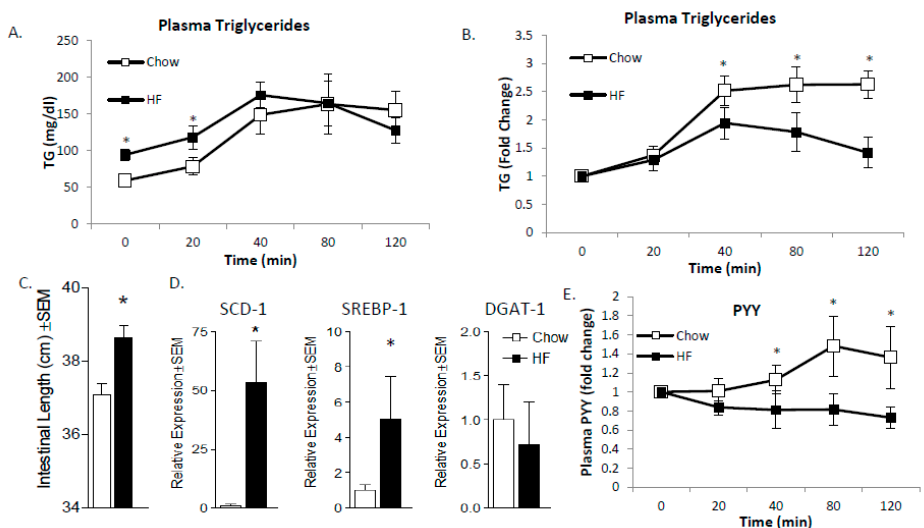
Figure 7. Intestine adaptations to HF diet. Mice were fed chow or high SFA diet for 12-weeks, then gavaged with an SFA-rich meal. Plasma TG following the gavage was measured as absolute ( A ) or relative ( B ). One week later, tissues were collected for analysis where intestinal length was measured and found to be longer in HF-fed mice ( C ). Additionally, lipogenic genes (SCD1 and SREBP1c but not DGAT1) were increased ( D ). High SFA-fed mice had lower satiety response to the gavage as determined by plasma PYY levels ( E ). These data indicate that chronic high SFA diets lead to increased clearance through increased absorptive area and lipogenic capacity which reduces post-meal satiety response. Data are represented as mean ± SEM; * p < 0.05.